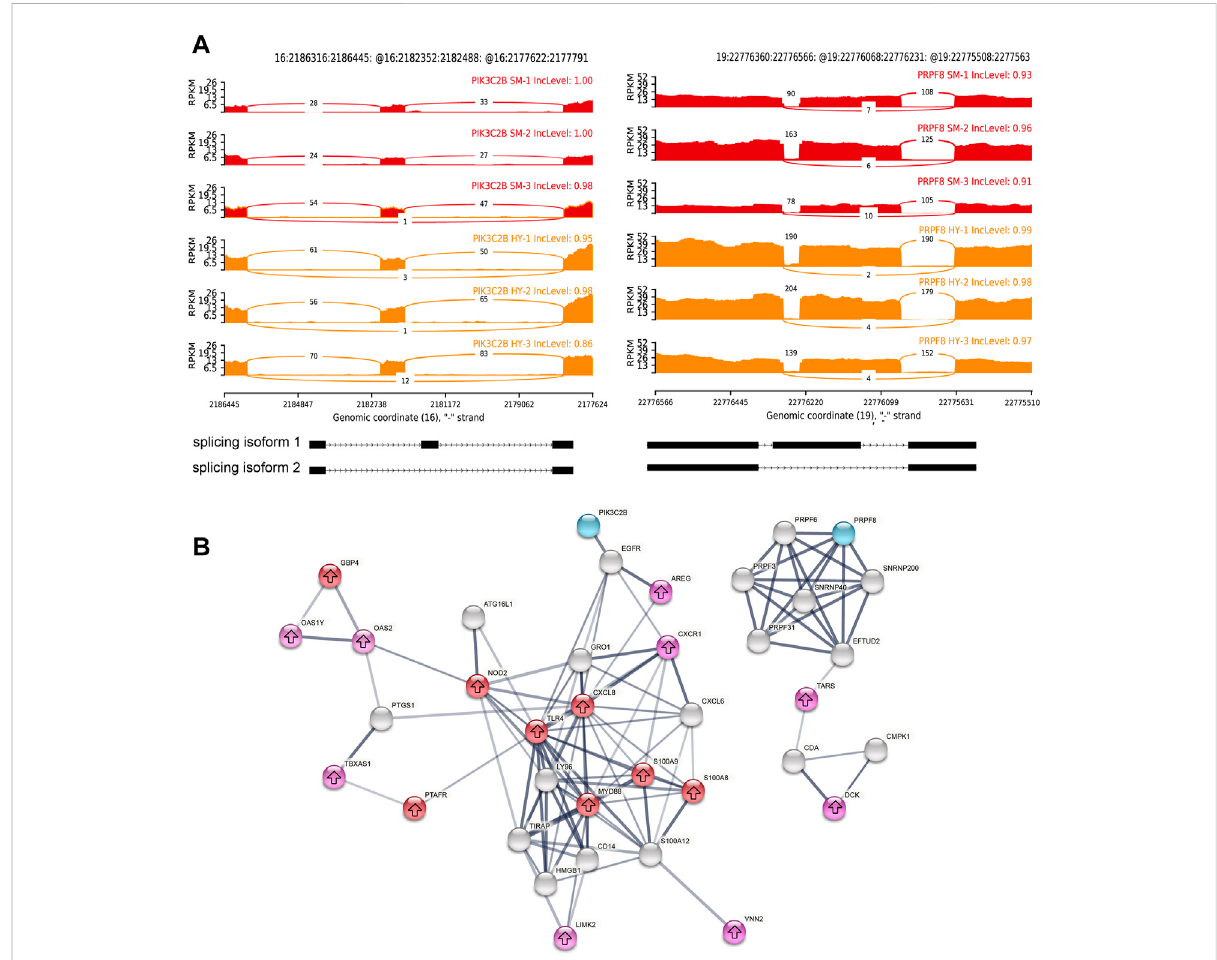
FIGURE 9 Interactingnetworksofalternativesplicinggenes,differentiallyexpressedgenes(DEGs),andthetargetgenesofdifferentiallyexpressedlncRNA (DELs). (A) differential alternative splicing (DAS) genes PIK3C2B and PRPF8 exhibited skipping exon (SE) events compared to healthy cows. Red representshealthycows(HY1,HY2,andHY3)andyellowrepresentssubclinicalmastitiscows(SM1,SM2,andSM3).Inclevelrepresentsinclusionlevel for sample replicates, and gene structure graph represents alternative splicing isoforms imputed from GTF fi les. (B) PPI network of subclinical mastitis resistance-associated genes. Purple nodes represents DEGs, red nodes represents the target genes of lncRNAs that were close to somatic cell count (SCC) and somatic cell score (SCS), and white cell count QTLs, blue nodes represents two DAS genes regulated by SNPs, and gray nodes represents the second shell of interactors. The thickness of the line represents the strength of the interaction, and the arrow represents the up- regulated